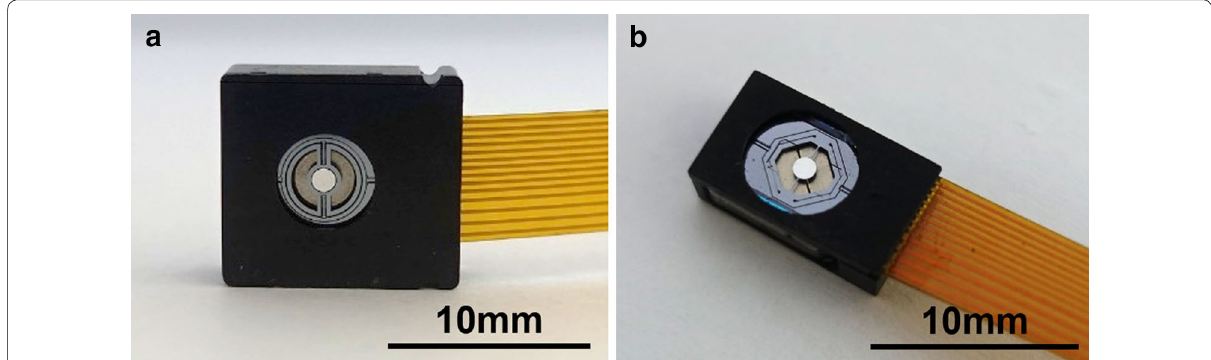
Fig. 1 Electromagnetic 2D scanning micromirrors used in the experiment: a low‑frequency scanner, b high‑frequency scanner